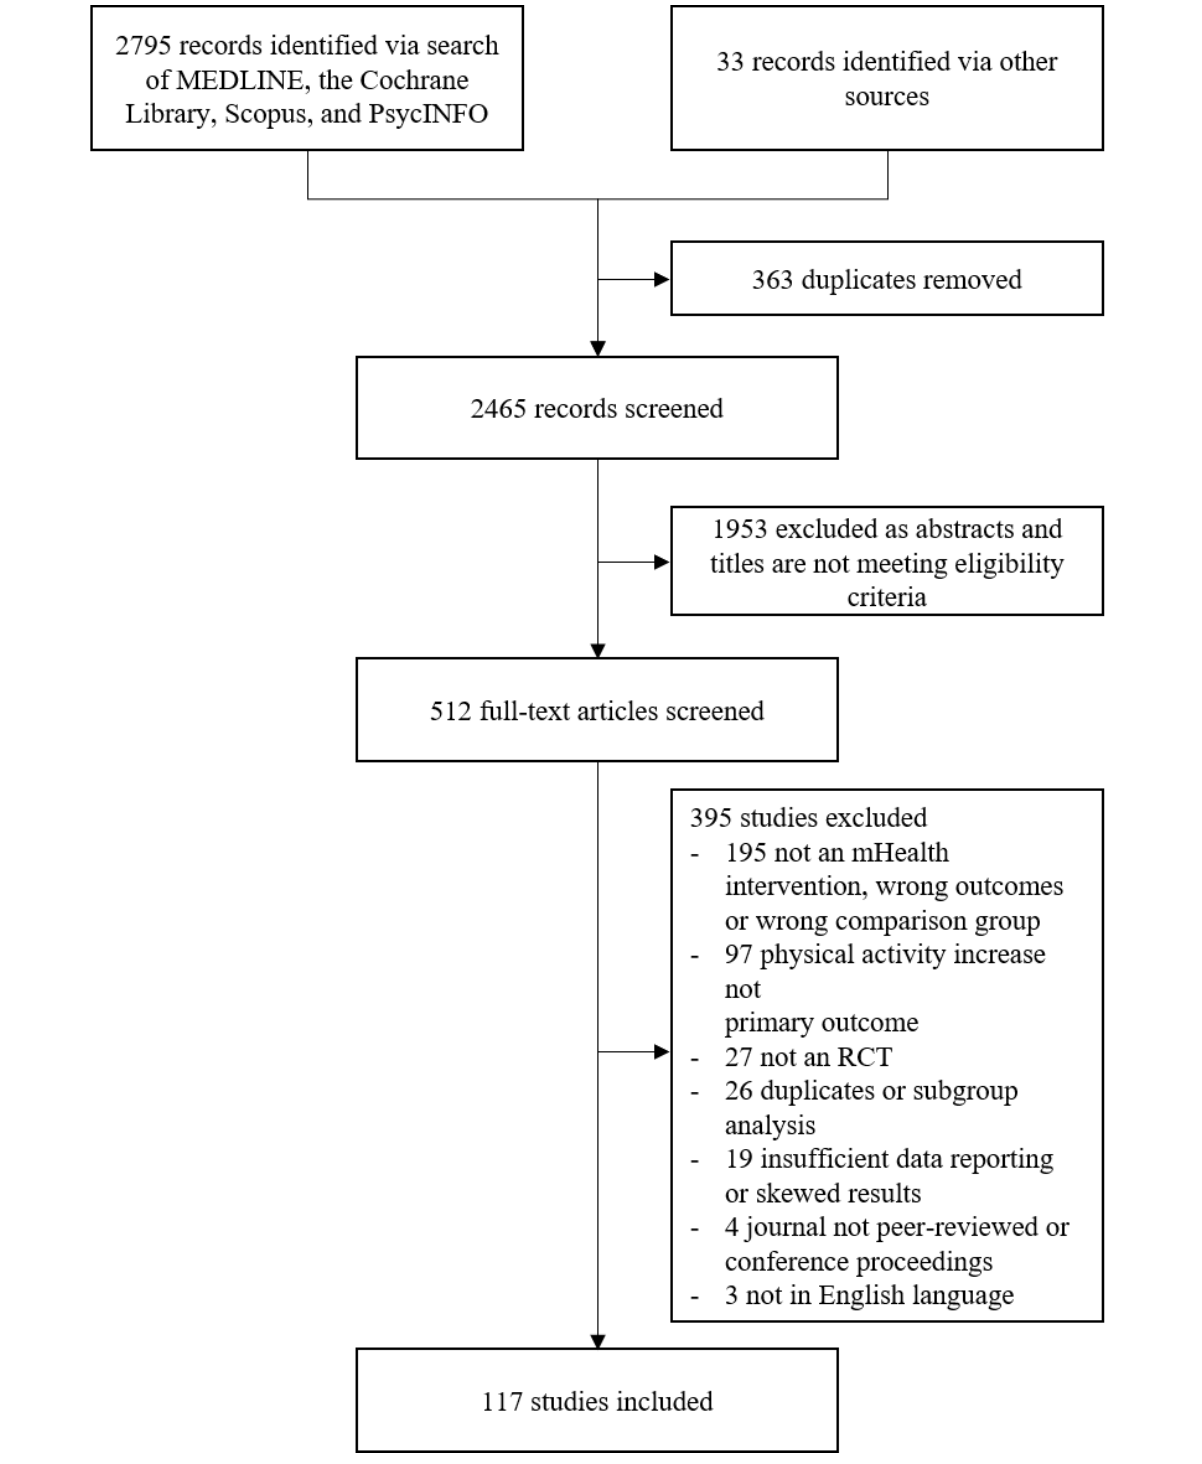
Figure 1. PRISMA (Preferred Reporting Items for Systematic Reviews and Meta-Analyses) chart. mHealth: mobile health; RCT: randomized controlled